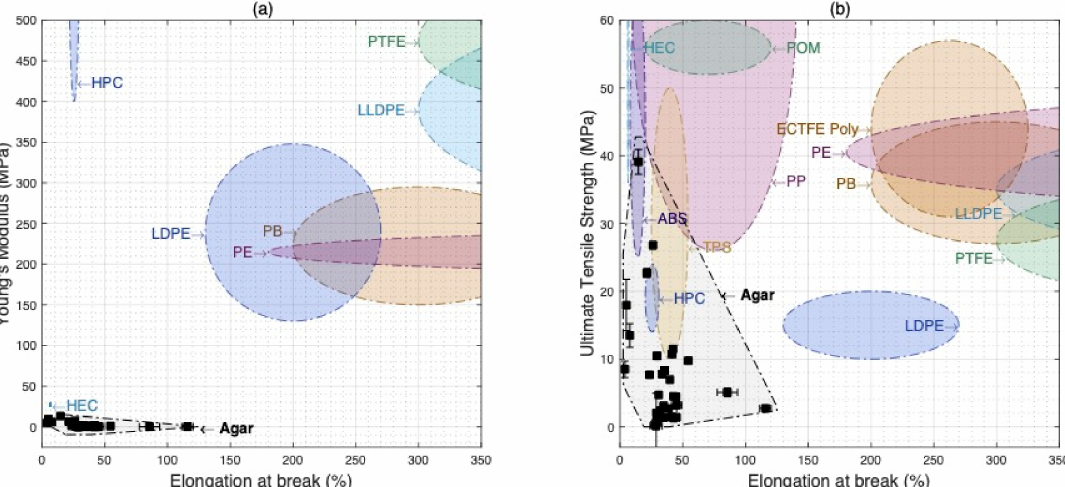
Figure 4. Material selection charts comparing agar biopolymer films to commercial polymer systems, illustrating ( a ) Young’s modulus versus elongation at break, and ( b ) ultimate tensile strength versus elongation at